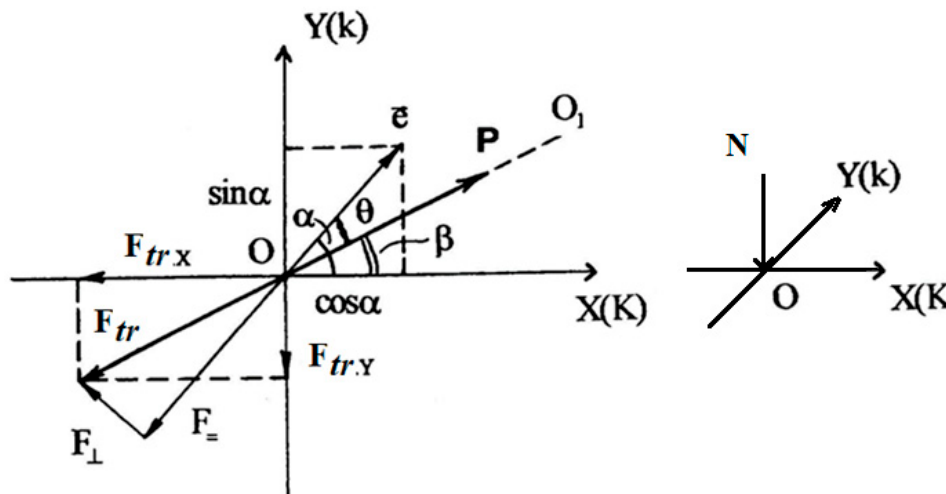
Figure 1. Scheme for the analysis of the process of anisotropic friction. A normal force N is applied to a point O in a direction orthogonal to the drawing plane. Strength not